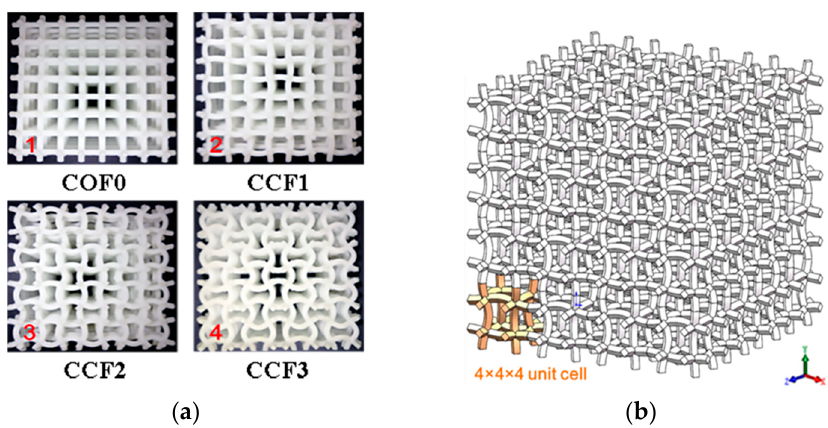
Figure 1. ( a ) Cubic unit cell model of the conventional open-cell foams with straight cell edges, of square cross sections, arranged in planes at forty-five degrees relative to each other, in which the edge length is l 0 and the edge thickness is t 0 ; ( b ) Cubic unit cell model of the negative Poisson’s ratio convex-concave foams, which are constructed by replacing cell edges of the conventional open cell foams of ( a ) with sine-shaped cell edges of equal mass but different square cross sections; ( c ) Schematic diagram of the sine-shaped cell edges of the convex-concave foams (CCF) with chord span l 0 , chord height h , and thickness t .